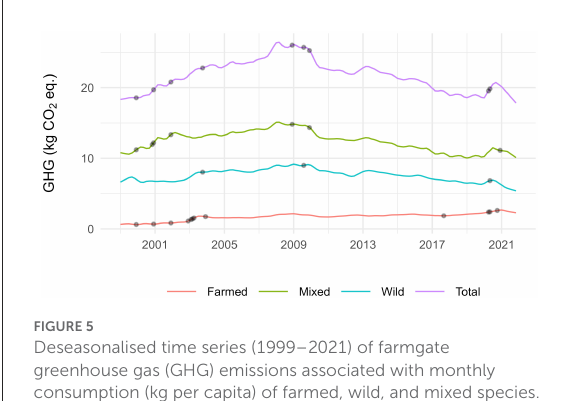
FIGURE5 Deseasonalised time series (1999–2021) of farmgate greenhouse gas (GHG) emissions associated with monthly consumption (kg per capita) of farmed, wild, and mixed species. Black dots denote anomalies detected with generalised extreme studentised